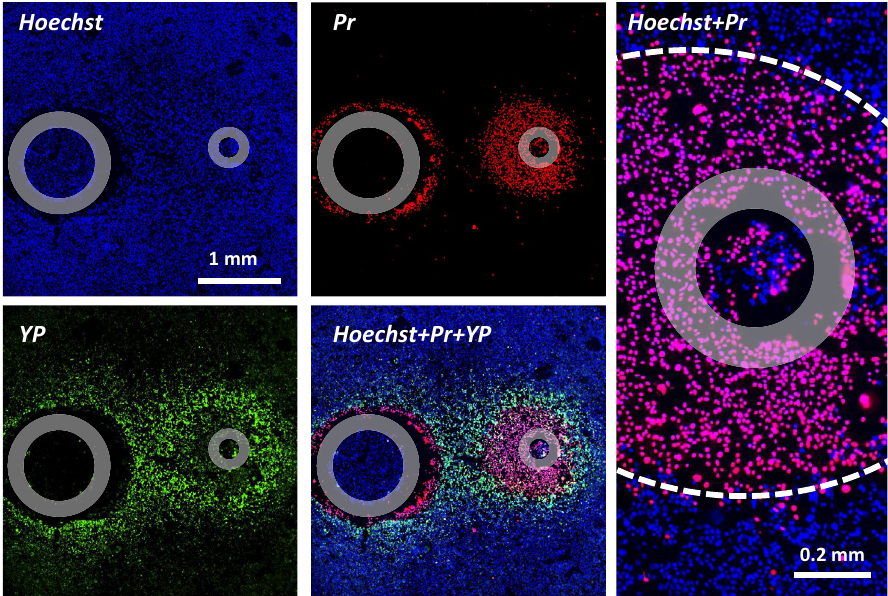
Figure 3. An example of fluorescent staining of cell monolayer for the determination of electric field thresholds for electroporation and cell death. Cells were exposed to 300 unipolar pulses (50 µs duration, 10 Hz, 150 V). Individual panels show the signal from Hoechst-33342 ( Hoechst ), YO-PRO-1 ( YP ), and propidium iodide ( Pr ) dyes, as well as their combinations as marked in the legends. Gray circles mark the footprints of the electrodes. Right panel shows the area near the anode at a higher magnification and the margins of the cell death area marked by a dashed white line. Note peeling of the monolayer near the cathode and quenching of YP signal by Pr. See text for more details.